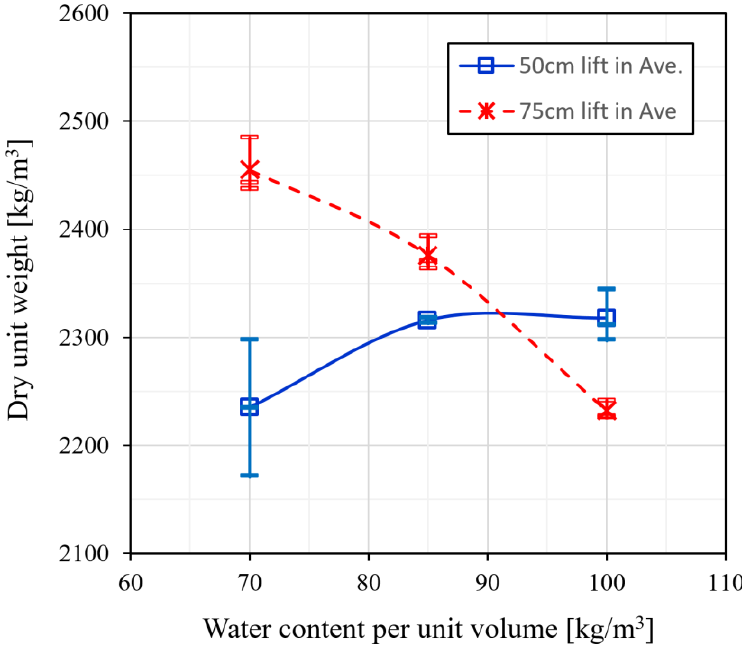
Figure 9. Compaction results for field-constructed hardfill (dry unit weight).